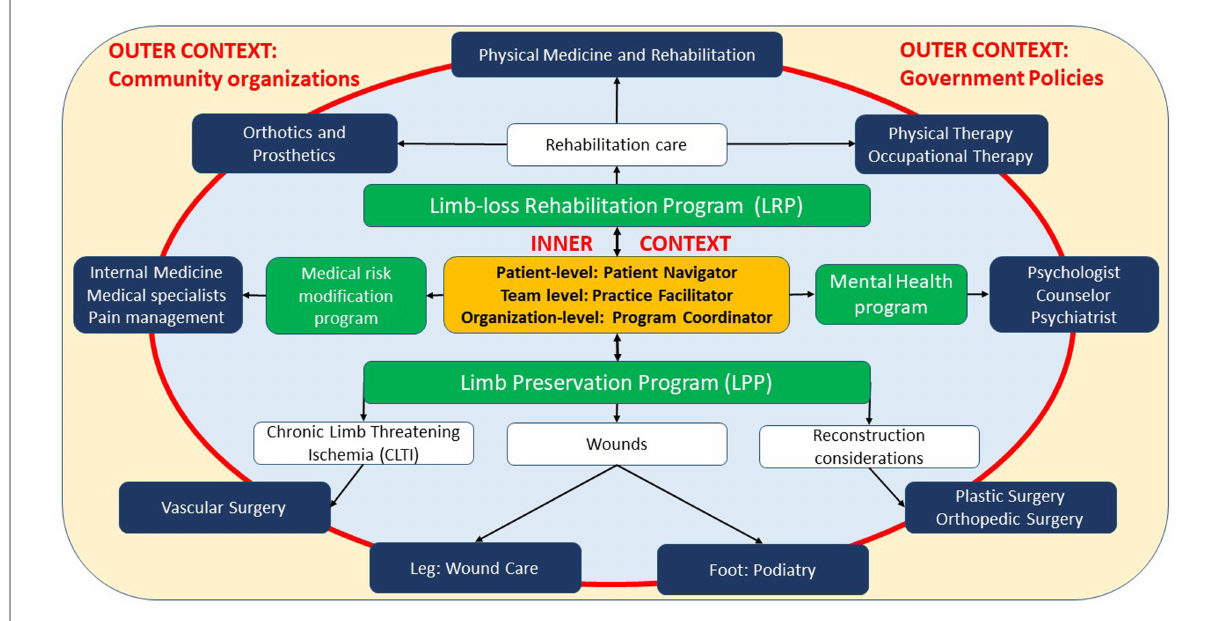
FIGURE 1 Model for comprehensive limb care though partnership between limb-loss rehabilitation, limb preservation, medical risk modi fi cation, and mental health